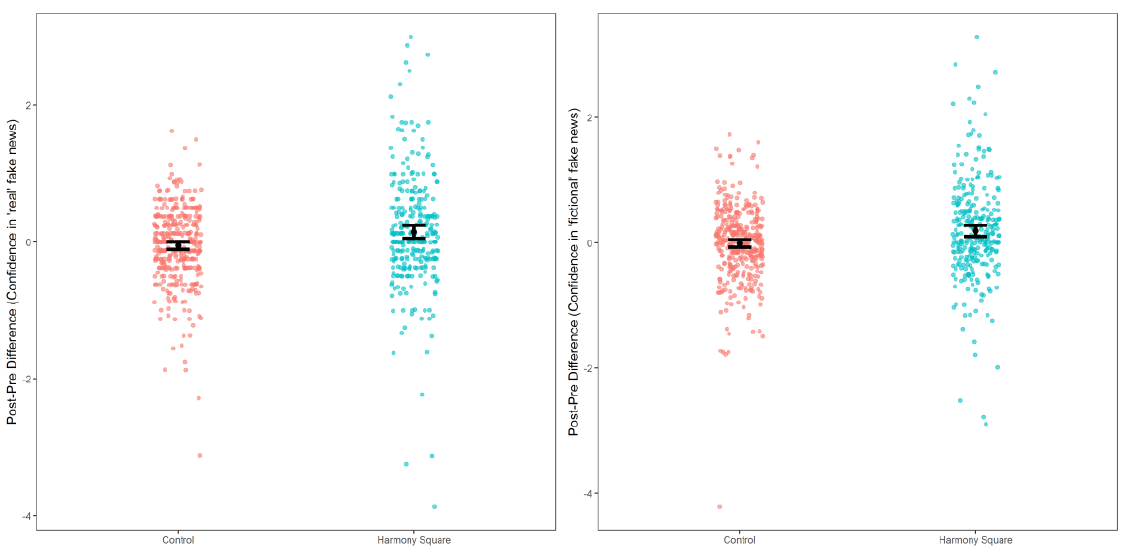
Figure 3. Pre-post d ifference scores for the confidence judgments for both “real” and “fictional” misinformation, for the treatment and control groups. The black dot in the middle indicates the mean value. Error bars represent 95% confidence intervals. In both plots, the distribution for the Harmony Square group is shifted upwards, indicating that people were significantly more confident in their judgments about misinformation after playing in the treatment group. Separate bars for pre and post scores (by condition) are provided in Supplementary Figure